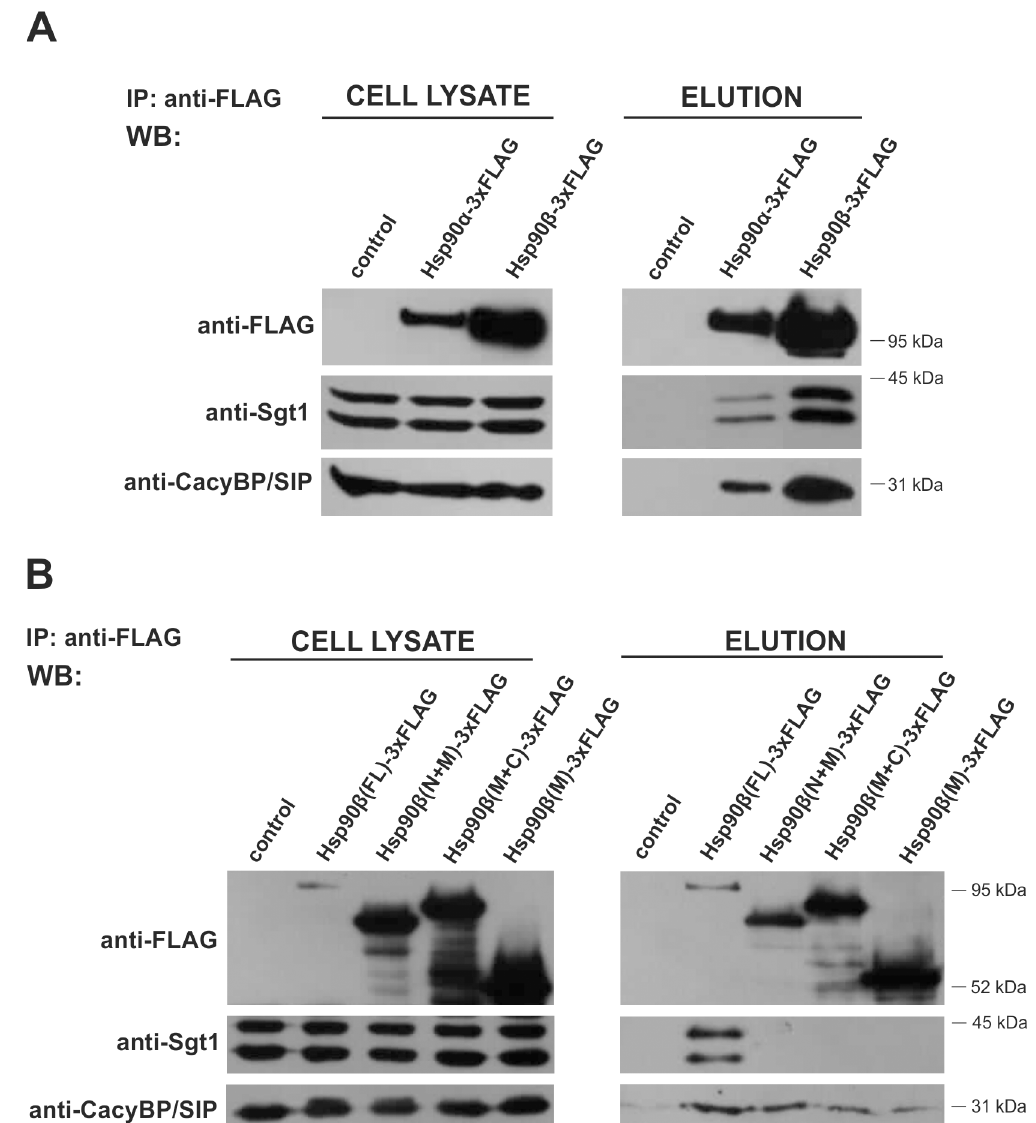
Fig 2. Hsp90-CacyBP/SIP complex formation. Co-immunoprecipitation of CacyBP/SIP and Sgt1 with (A) FLAG- tagged Hsp90 α and Hsp90 β or (B) full-length Hsp90 β (FL) and its deletion mutants containing N-terminal + middle domains (N+M), middle + C-terminal (M+C) or middle (M) domains. Anti-FLAG staining shows expression of Hsp90 α -3xFLAG, Hsp90 β -3xFLAG and FLAG-tagged Hsp90 β deletion mutants. For control, HEp-2 cells were transfected with plasmid encoding 3xFLAG alone. A representative Western blot, out of 3 performed, is shown.